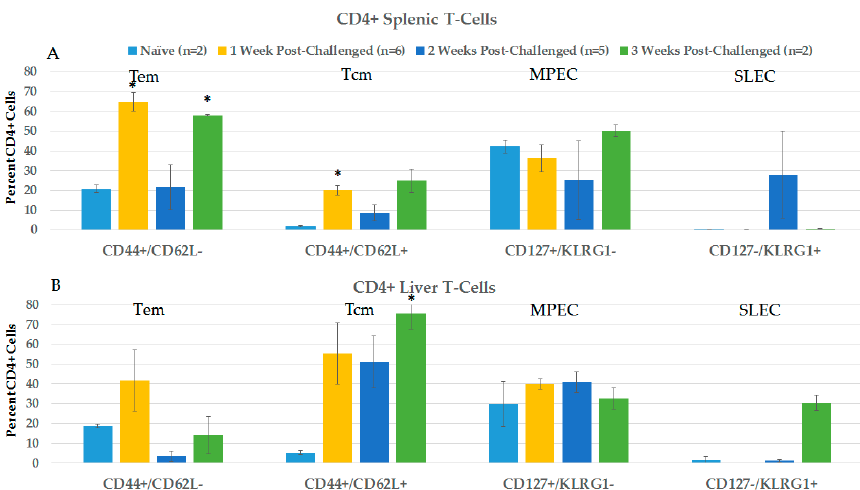
Figure 8. Spleen and liver CD4+ T-Cell analysis post-challenge. Lymphocytes were isolated at various times post-challenge from the spleen ( A ) and liver ( B ), and then stained with CD4, CD8, CD44, CD62L, CD127 and KLRG1. Analyses were done on CD4+ cells. Naïve and 3 weeks n = 2, 1 week n = 6, and 2 weeks n = 5; error bars = SEM. * p = 0.05.